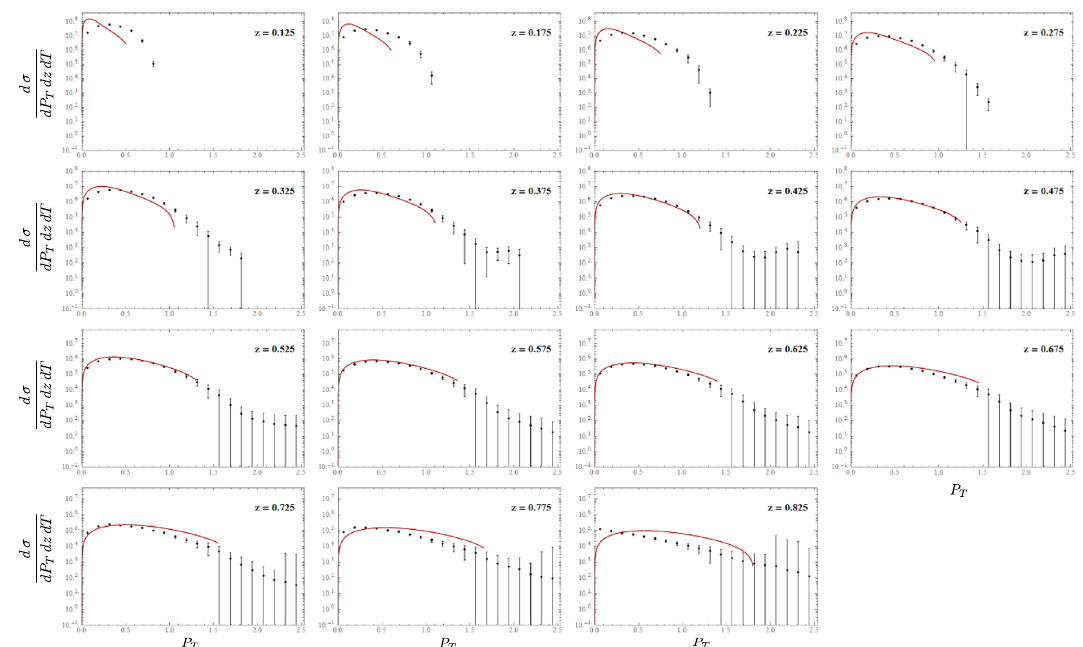
Figure 6 . The e + e − → hX cross section computed to NLO and NLL accuracy, corresponding to 15 z -bins as measured by the BELLE Collaboration. The central values of the z h in each panel. Thrust is fixed to one bin, corresponding to 0 . 85 < T < 0 . 9 . Uncertainty bands are not shown as no fit is involved in this computation. The collinear fragmentation functions used for the implementation of eq. (4.5) are the NNFF10_NLO reference set [38], for π + production. Uncertainties due to the errors on the collinear fragmentation functions are not